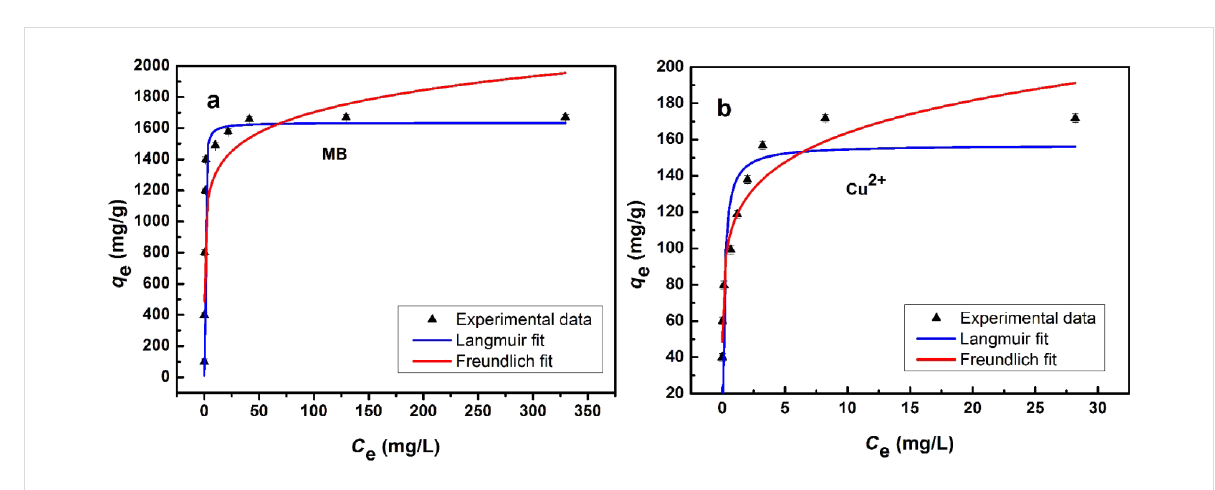
Figure 7: Adsorption isotherms of MB (a) and Cu2+ (b) on Lys-GO.